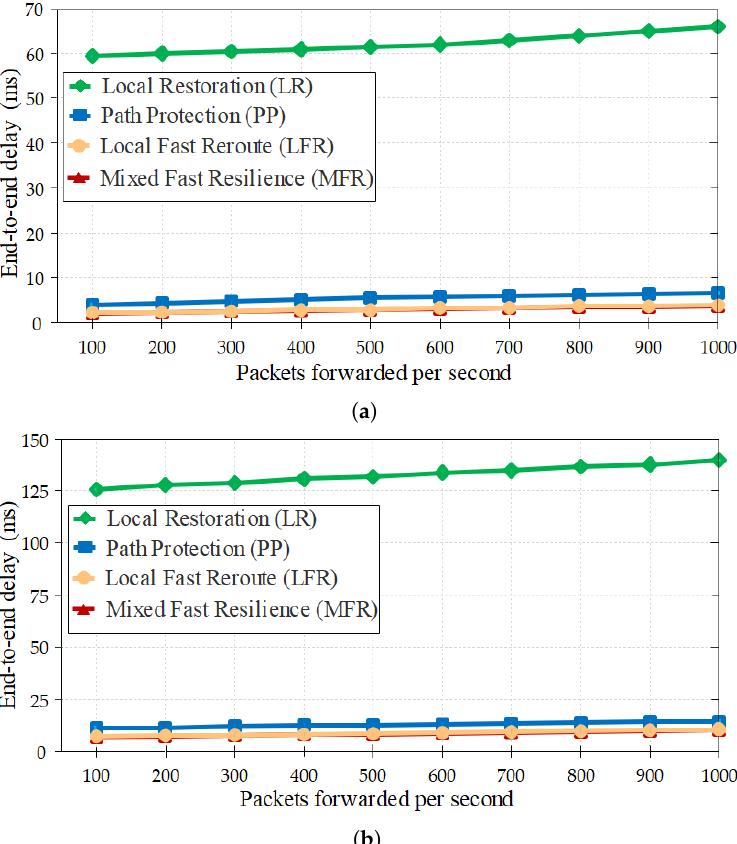
Figure 9. End-to-end delay before a link failure. ( a ) To the industrial network topology. ( b ) To the sprint